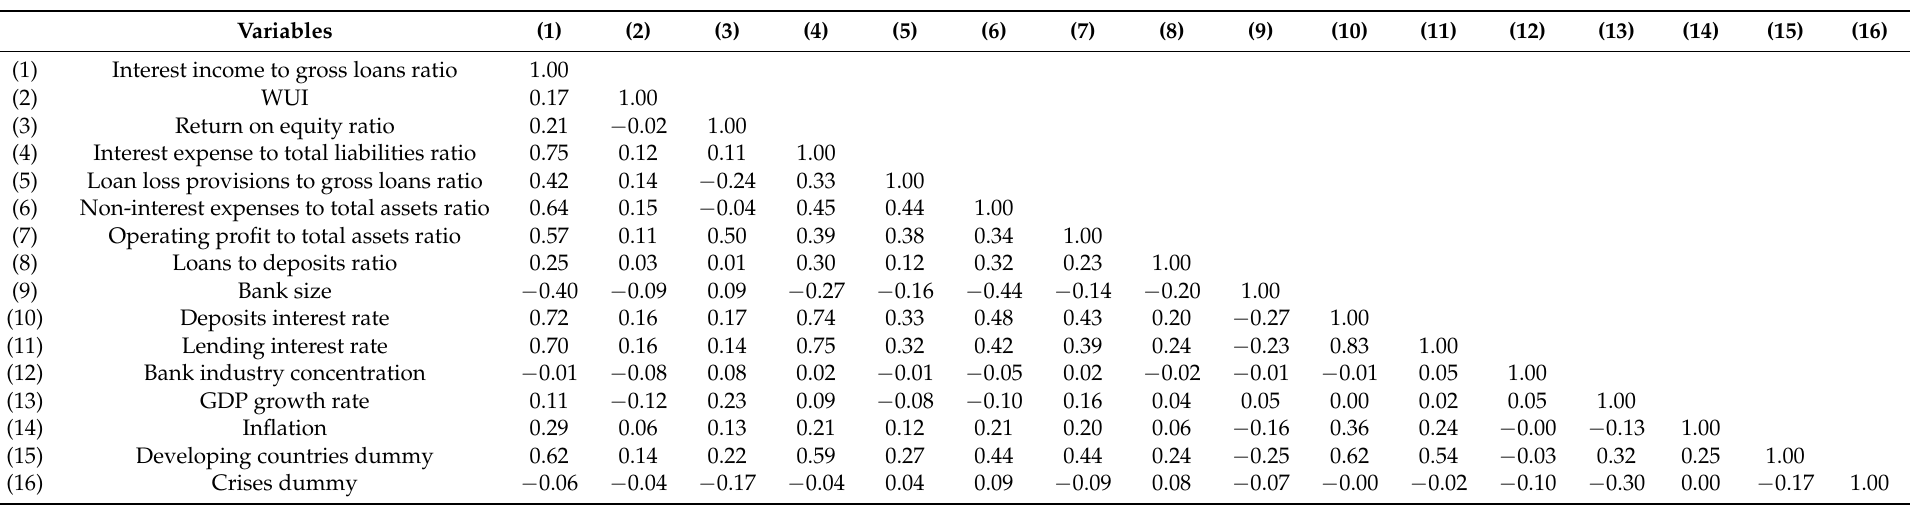
Table 4. Matrix of pair-wise correlations between variables. This table reports pair-wise Pearson correlations between variables. All correlations are significant at the 5% level except those in